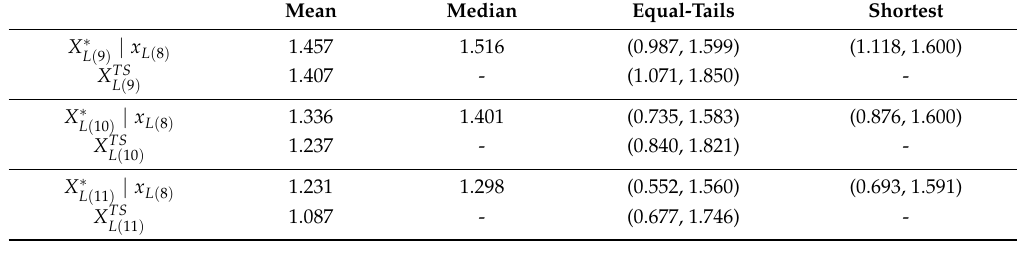
Table 4. Prediction results.